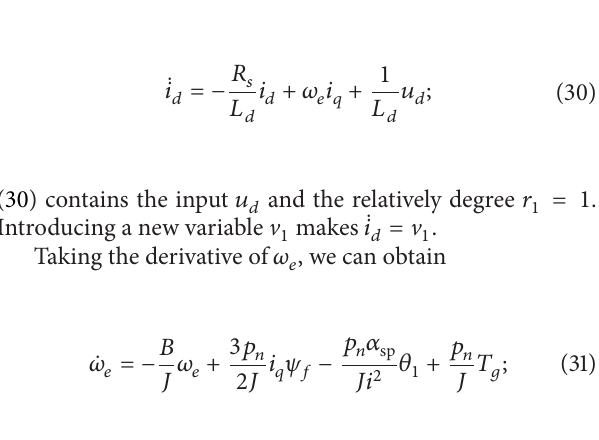
Table 2: Operation parameters of a 0.16kWh/0.8 kW MEES